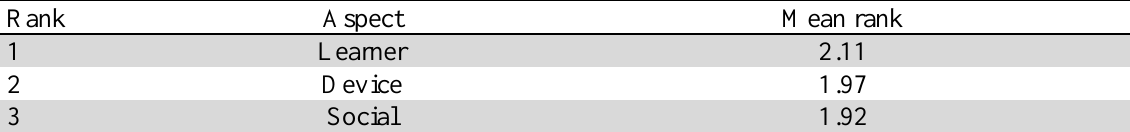
The summary of Freedman